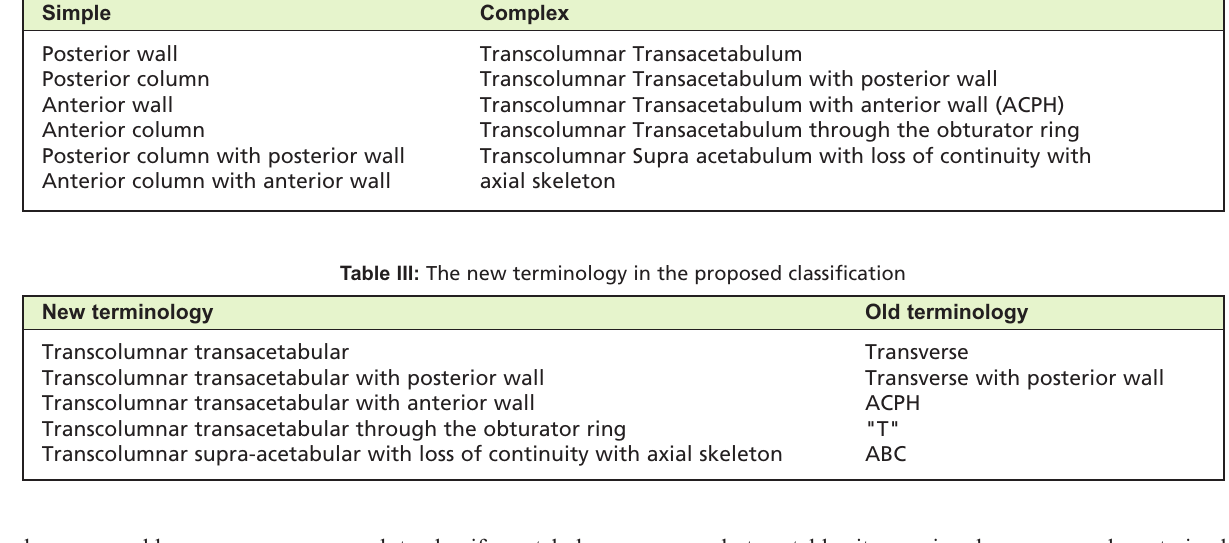
Classification of acetabular fractures as proposed by Author Table II: